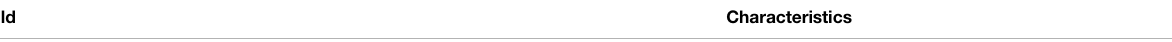
Low pro fi le Species of short stature, either prostrate, adnate, or erect, along with solitary-centric and slow-moving species. High pro fi le Species of tall stature; erect, fi lamentous, branched, chain-forming, tube-forming, stalked, and colonial-centric species. Motile Species with active